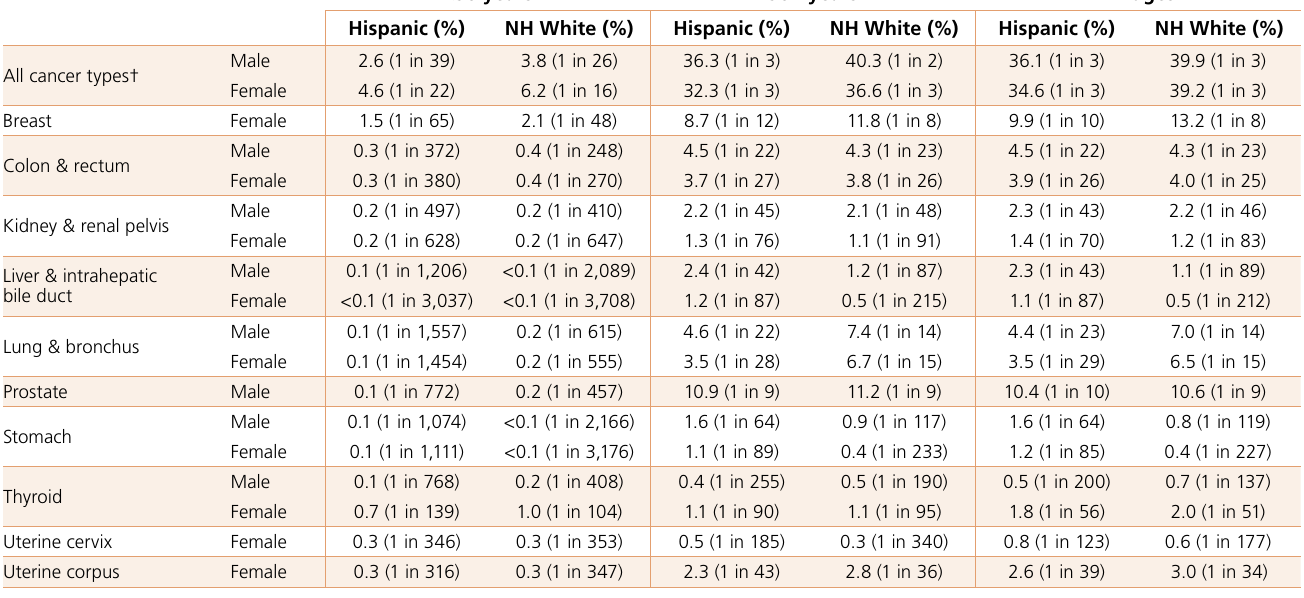
Table 1. Probability (%) of Developing Invasive Cancer during Selected Age Intervals by Race/Ethnicity and Sex, US,